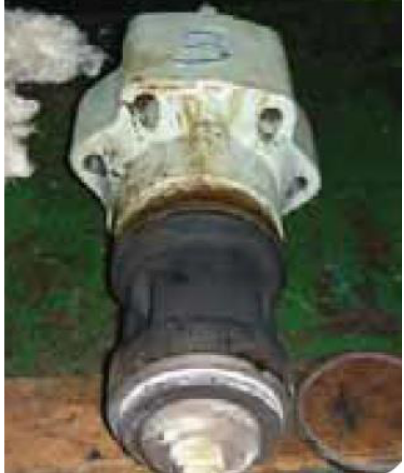
Figure 3. Photograph of the starting valve removed from the engine after an explosion in the starting air manifold (Royal Belgian Institute of Marine Engineers 2009).